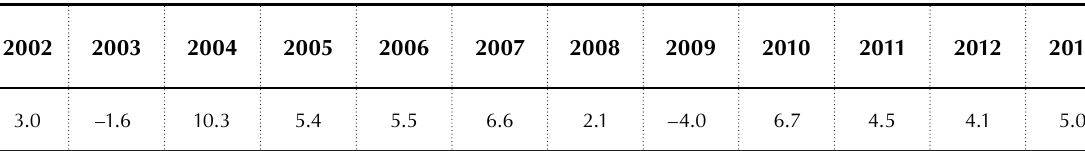
Table 2. Year-to-year development of tourism over the period of 10 years (%)